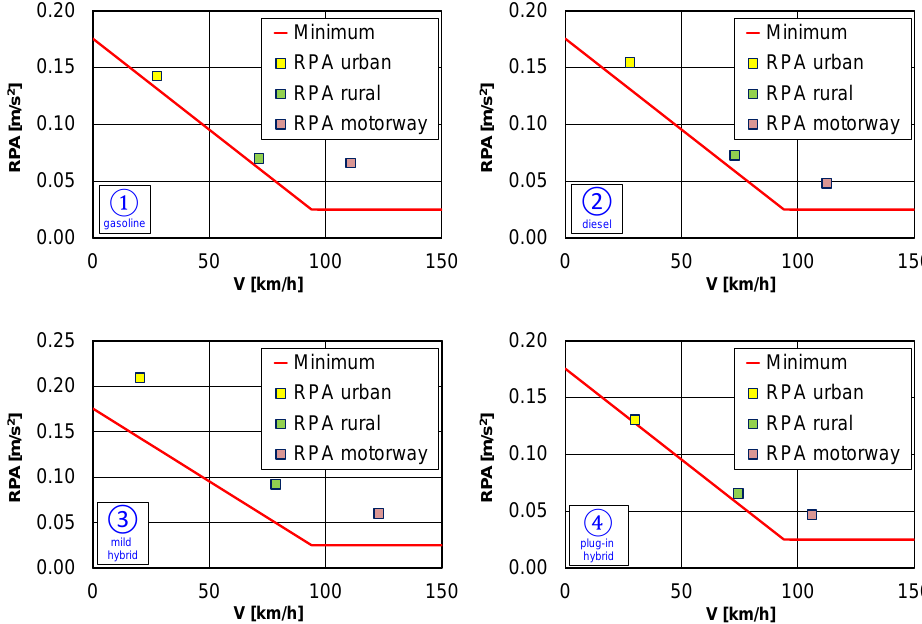
Figure 8. Values of relative positive acceleration compared to the RDE limits for average RPA for vehicle 1 – 4; 1 — gasoline, 2 — diesel, 3 — mild hybrid, 4 — plug-in hybrid.